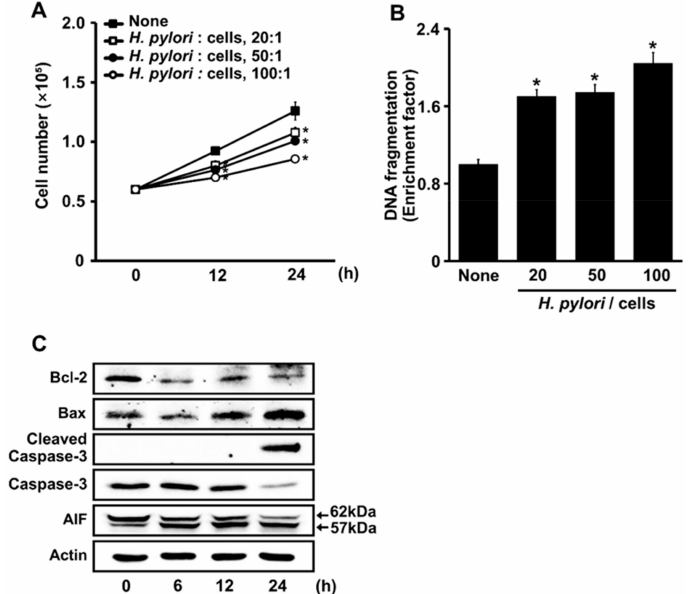
Figure 1. H. pylori increases the rates of cell death, DNA fragmentation, and apoptosis indices (Bcl-2, Bax, caspase-3, and AIF) in AGS cells. ( A ). The cells were stimulated without ( (cid:4) ) or with ratios of H. pylori to bacteria of 20:1 ( (cid:3) ), 50:1 ( • ), and 100:1 ( ), for up to 24 h. Viable cells were determined (cid:35) by trypan blue exclusion. All data are shown as means ± S.E. of three independent experiments. * p < 0.05 vs. unstimulated cells (None). ( B ) Cells were stimulated with H. pylori at indicated ratios of bacteria to cells for 24 h. DNA fragmentation, expressed as an enrichment factor, of unstimulated cells (None) was set at 1. All data are shown as means ± S.E. of three independent experiments. * p < 0.05 vs. unstimulated cells (None). ( C ) The cells were stimulated with 100:1 ratio of H. pylori to cells for indicated periods. Levels of Bcl-2, Bax, caspase 3, cleaved caspase 3, and truncated AIF in whole-cell extracts were determined by Western blotting. Actin was the loading control. AIF, apoptosis-inducing